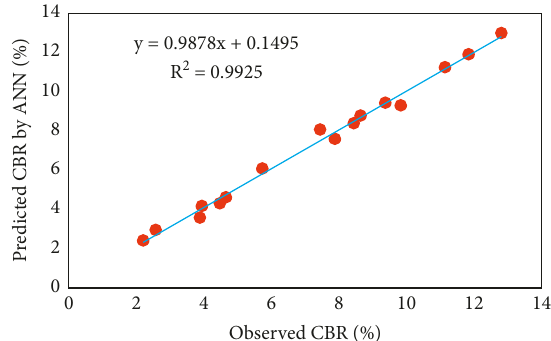
Figure 24: Predicted CBR by ANN versus experimental